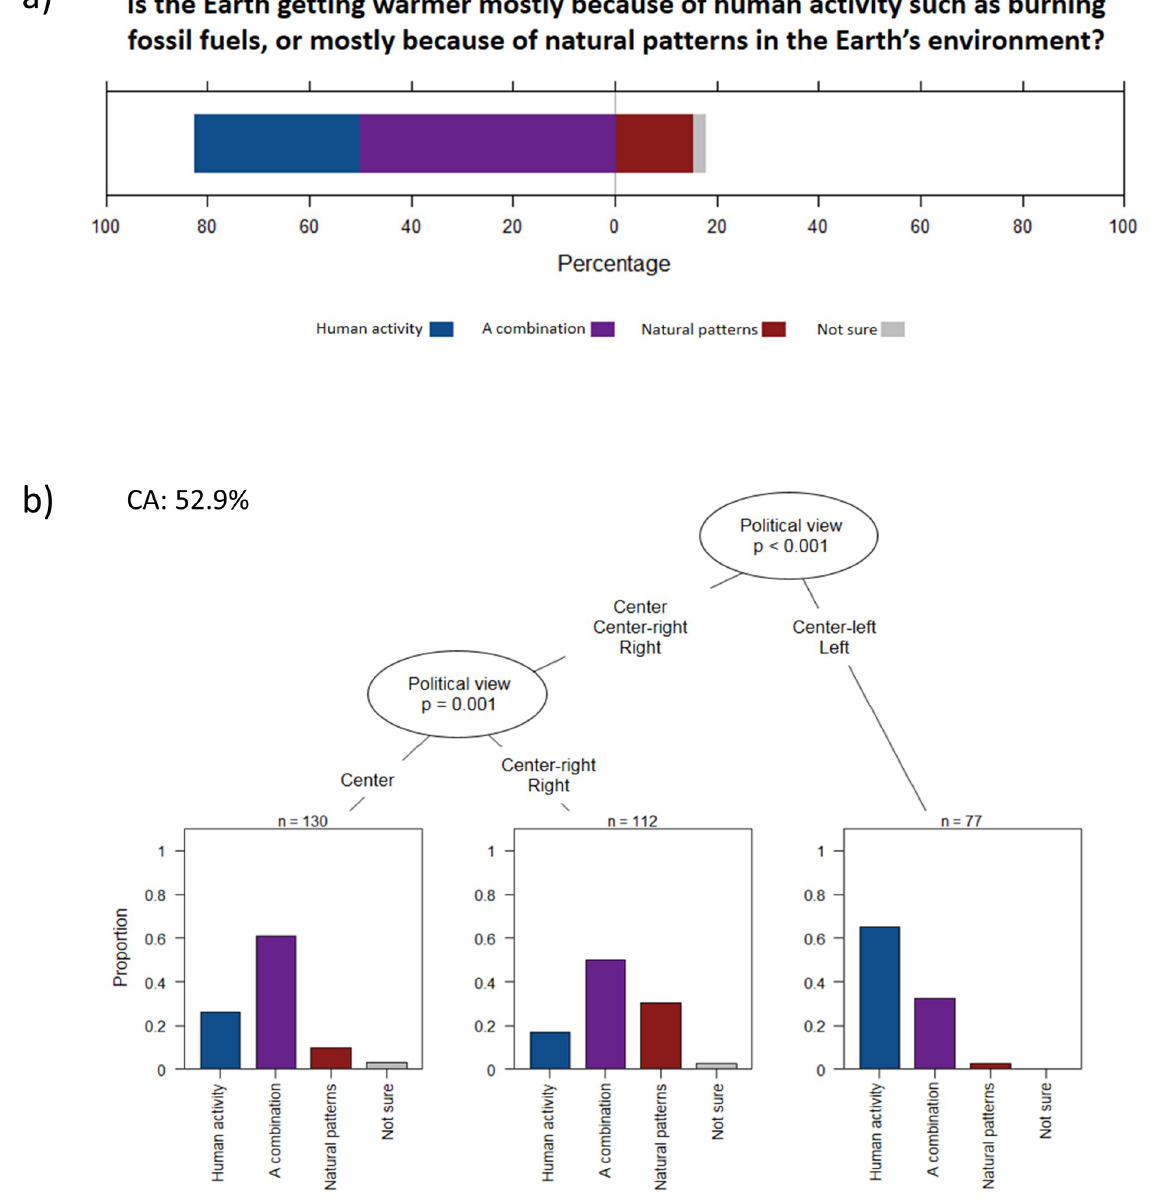
Fig 3. Causes of climate change. a) Responses of the survey participants for the question Is the Earth getting warmer mostly because of human activity such as burning fossil fuels or mostly because of natural patterns in the Earth’s environment ? b) Conditional inference classification tree predicting the responses. Only significant predictors at p < 0.05 were retained by the algorithm. Sample size used to build the tree can be calculated by adding sample sizes indicated at each terminal node. CA value is the classification